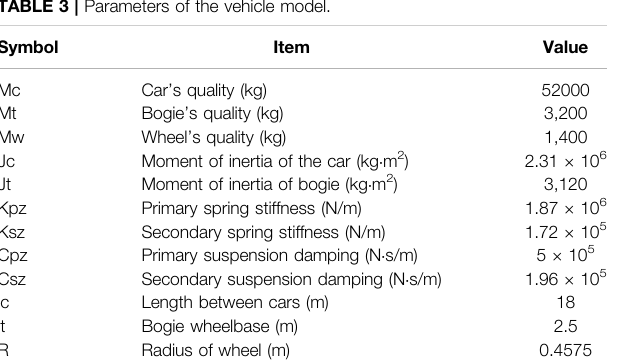
TABLE 3 | Parameters of the vehicle